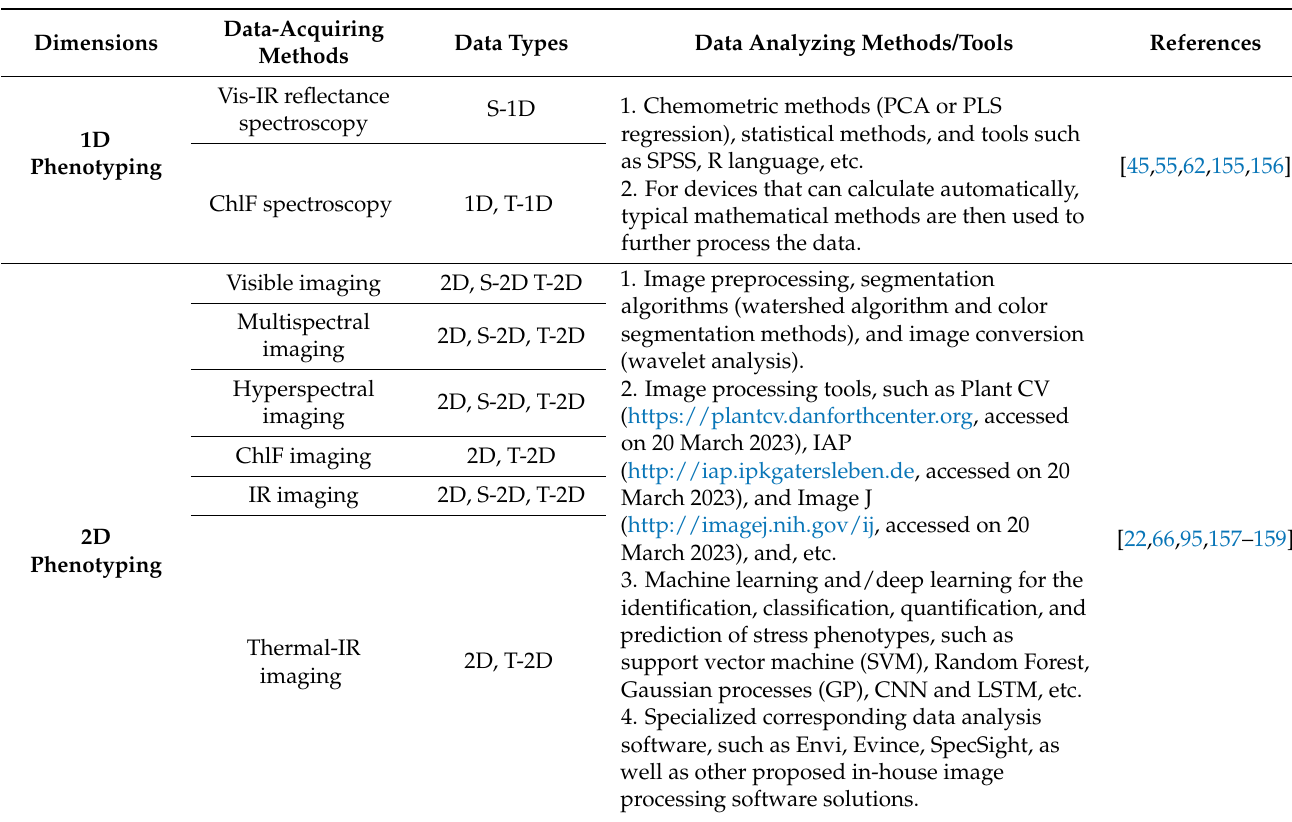
Table 2. Data-acquiring and corresponding data-processing methods of various dimensions of plant stress